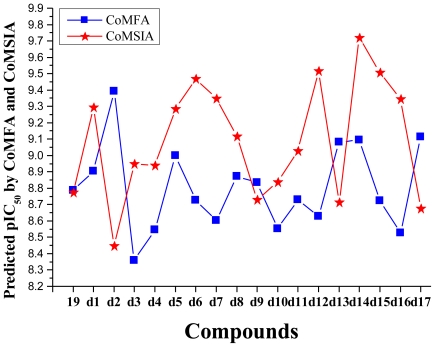
Graph of the predicted pIC50 of the newly designed molecules versus compound 19.